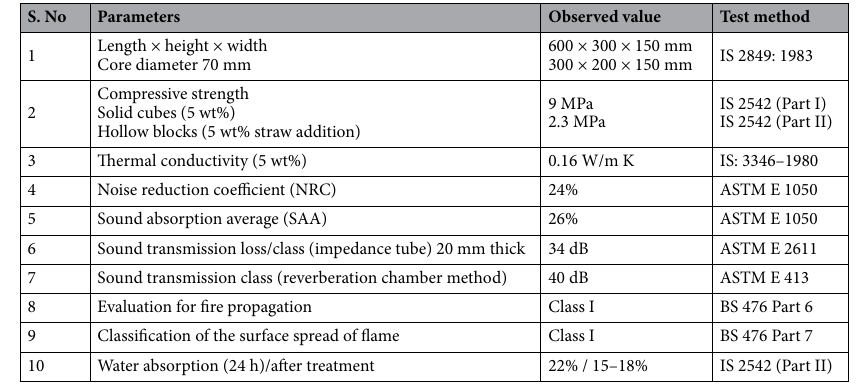
Table 2. Test results of agro-waste gypsum samples and their observed